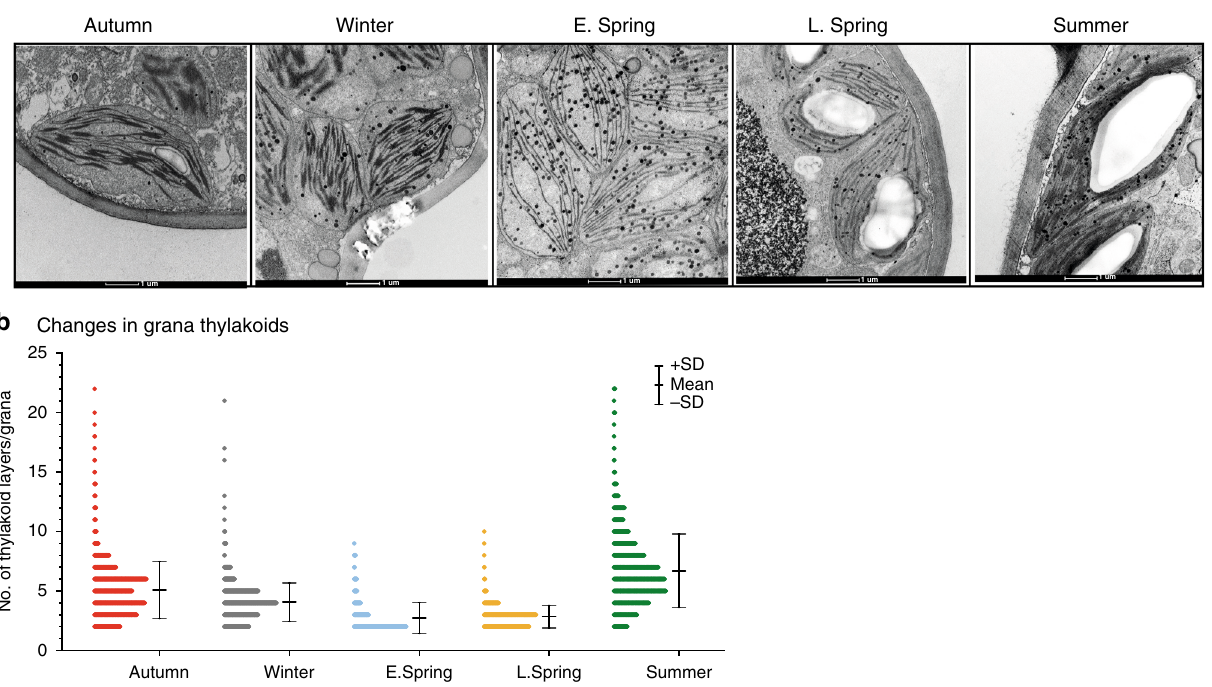
Fig. 4 Transmission electron microphotographs depicting seasonal variations in chloroplast ultrastructure in pine needles. a Chloroplast structure in Autumn, Winter, E. Spring, L. Spring, and Summer. b Histograms of frequency distributions of numbers of thylakoids per granum during the fi ve distinct seasonal periods. The histograms were calculated from 80 – 100 electron micrographs per season, representing 2 – 3 chloroplasts per image [Error bars indicate mean ± SD calculated from n = 1124 (Autumn), 1235 (Winter), 521 (Early Spring), 578 (Late Spring) and 1048 (Summer) of grana